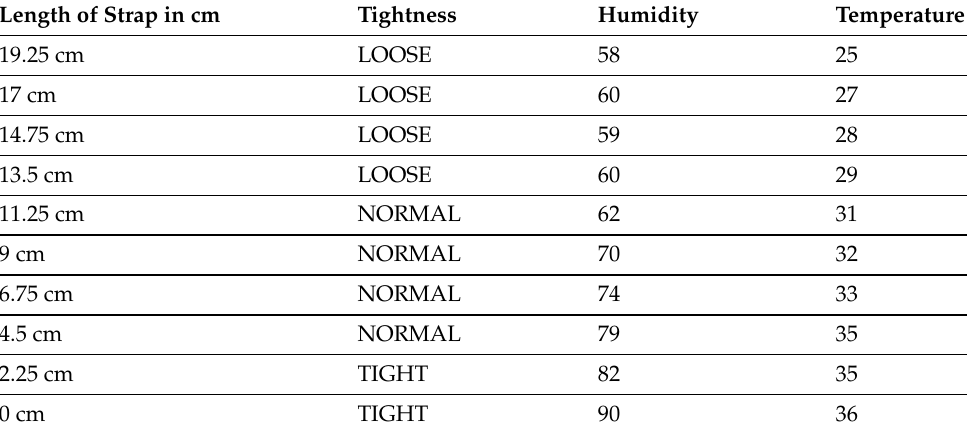
Table 5. Temperature and humidity with varied tightness with a surgical